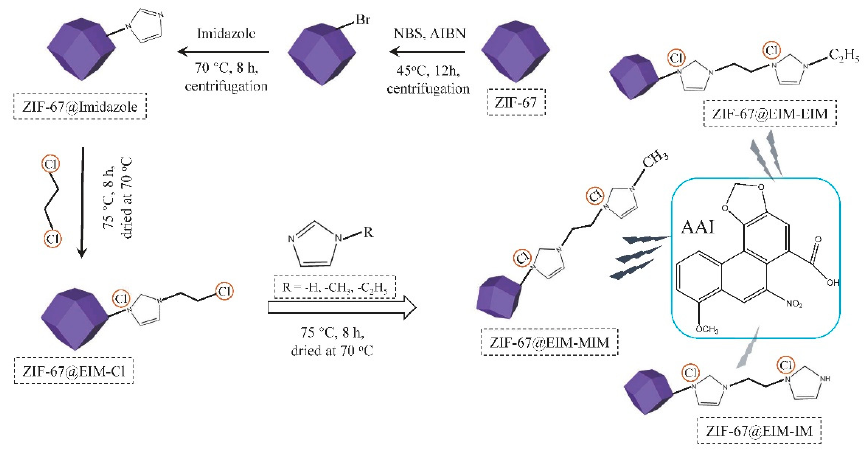
Figure 1. Synthesis process of dual IL-immobilized ZIF-67 sorbents.